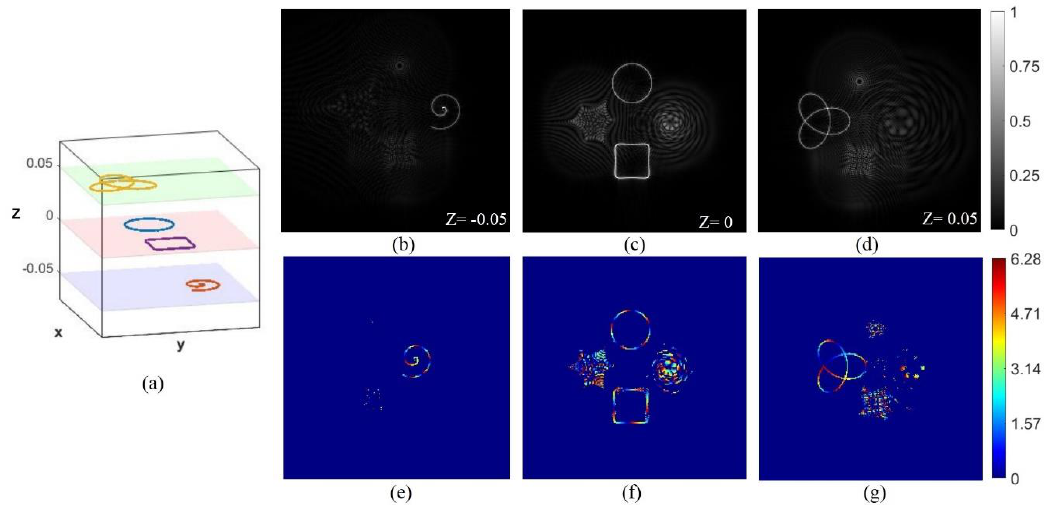
Figure 4. The beams focused on different regions. A three-dimensional schematic of focused beams is seen in ( a ). Intensity distribution of the beams projected in the focal plane (z = 0) seen in ( c ), and the Archimedean spiral and the trefoil-knotted curve are focused on the z = − 0.05 m and z = 0.05 m planes, respectively, seen in ( b , d ). ( e – g ) The phase distribution of the multiple light beams.